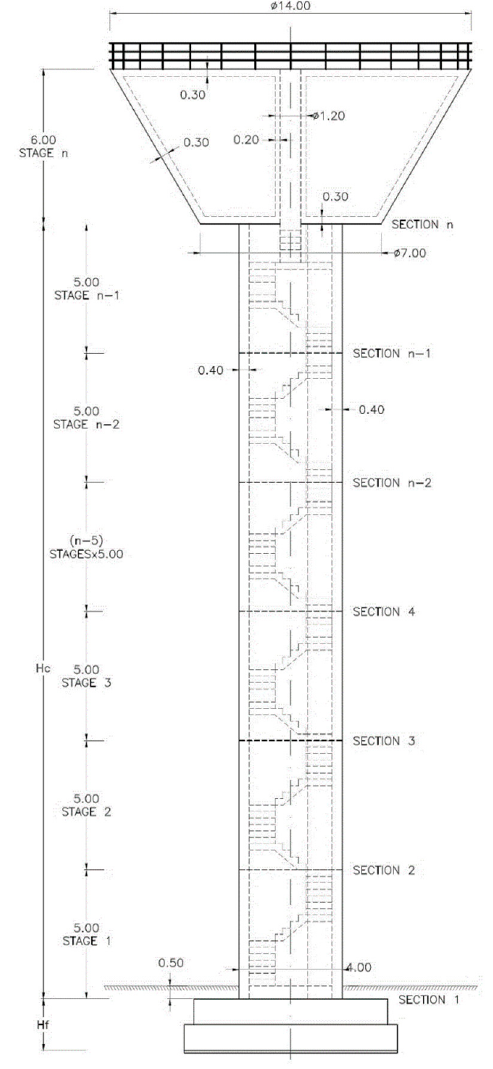
Figure 2. Typical elevation of an elevated water tank.